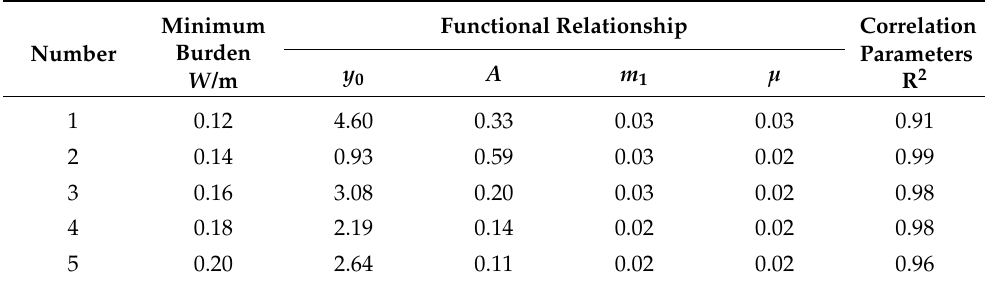
Table 5. The function relationship between the initial casting velocity of the particle and the y- coordinate value.